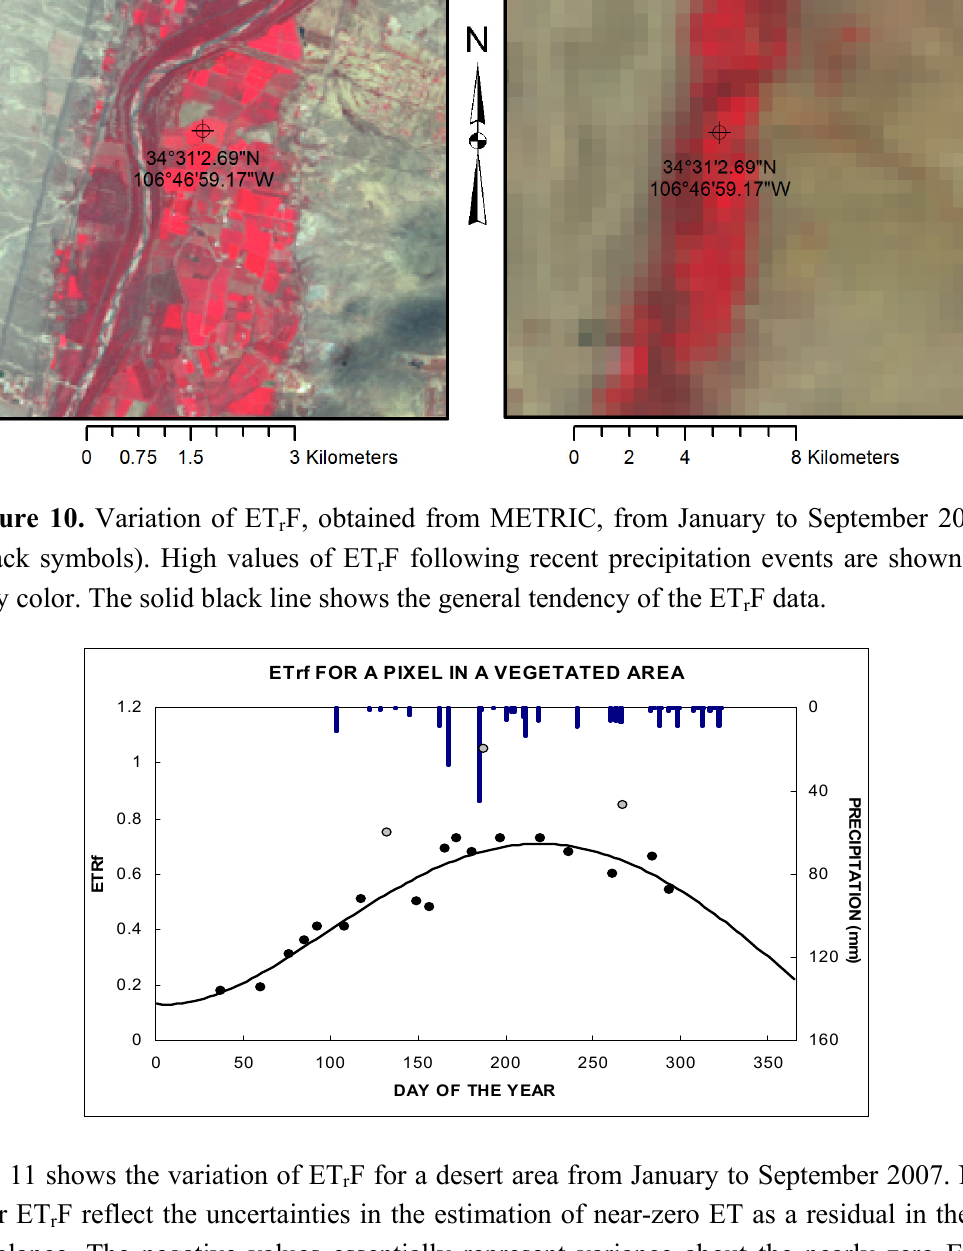
Figure 9. Location of an agricultural pixel (circular cross-hair) used to plot ET in Figure 10. ( Left ) Landsat 5 image used as a reference (08/16/2007). ( Right ) MODIS image (08/24/2007).